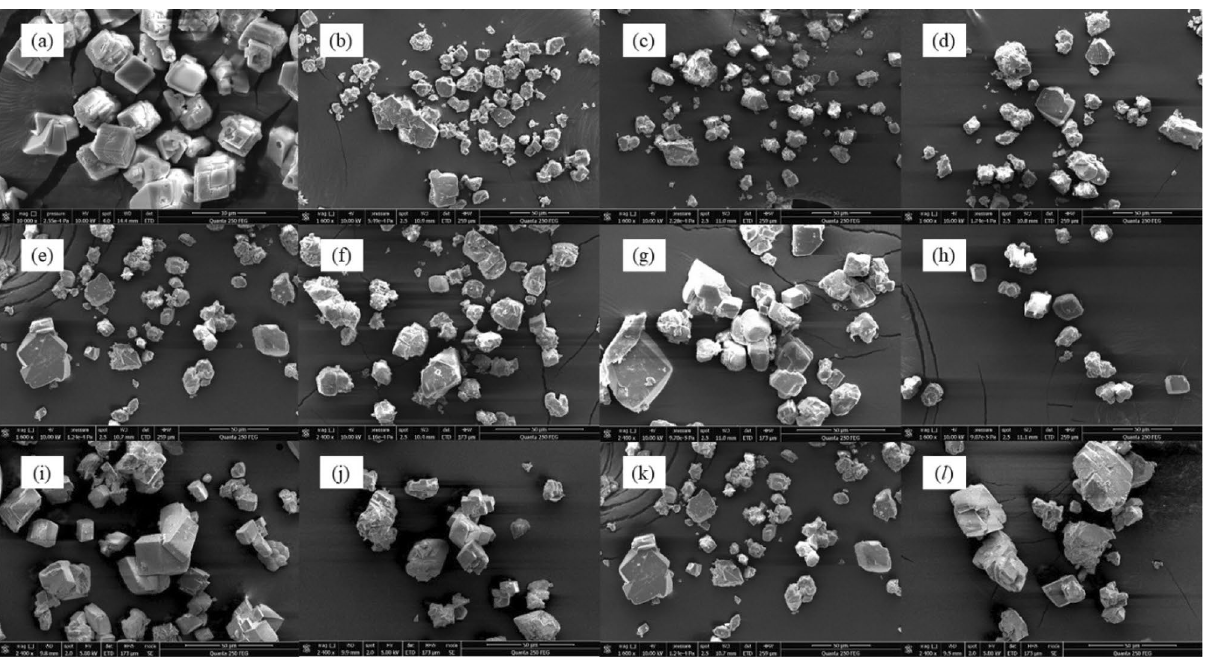
Figure 4. SEM images of CaCO 3 prepared from CaCl 2 and NaHCO 3 aqueous mixtures ( a ) in the absence of antiscalants; ( b – h ) in the presence of various CMC- g -PAA samples with different grafting ratio: ( b ) CMC- g - PAA(1), ( c ) CMC- g -PAA(2), ( d ) CMC- g -PAA(3), ( e ) CMC- g -PAA(4), ( f ) CMC- g -PAA(5), ( g ) CMC- g -PAA(6) and ( h ) CMC- g -PAA(7); and ( i – l ) in the presence of various CMC- g -PAA samples with different grafted-chain distributions: ( i ) CMC- g -PAA(a), ( j ) CMC- g -PAA(b), ( k ) CMC- g -PAA( c ) and ( l ) CMC- g -PAA( d ),